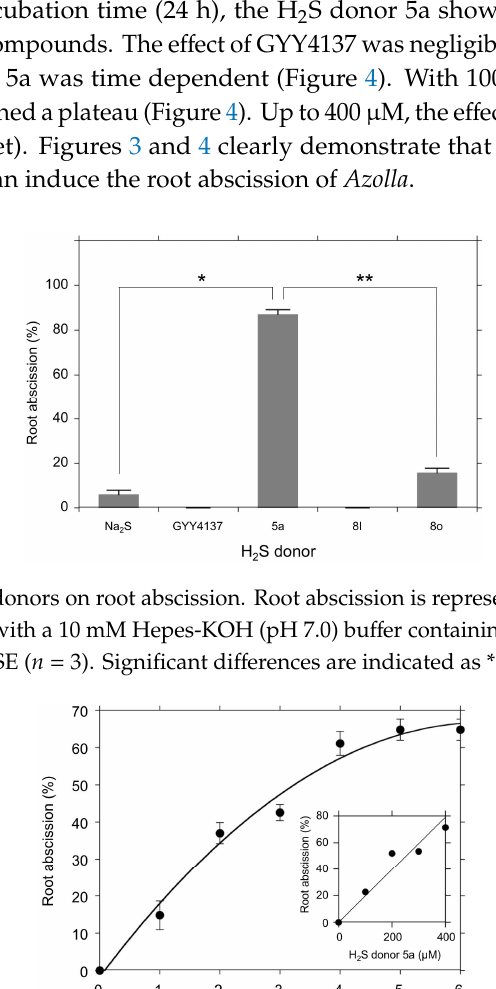
Figure 4. Time course of the root abscission induced by the H 2 S donor 5a. The number of detached roots was counted every hour after the addition of the H 2 S donor 5a (100 µM) into a 10 mM Hepes‐ KOH (pH 7.0) buffer. Means ± SE ( n = 3). Inset shows the 5a concentration dependence of the root abscission. The values are expressed as % of the detached roots after one‐hour incubation.